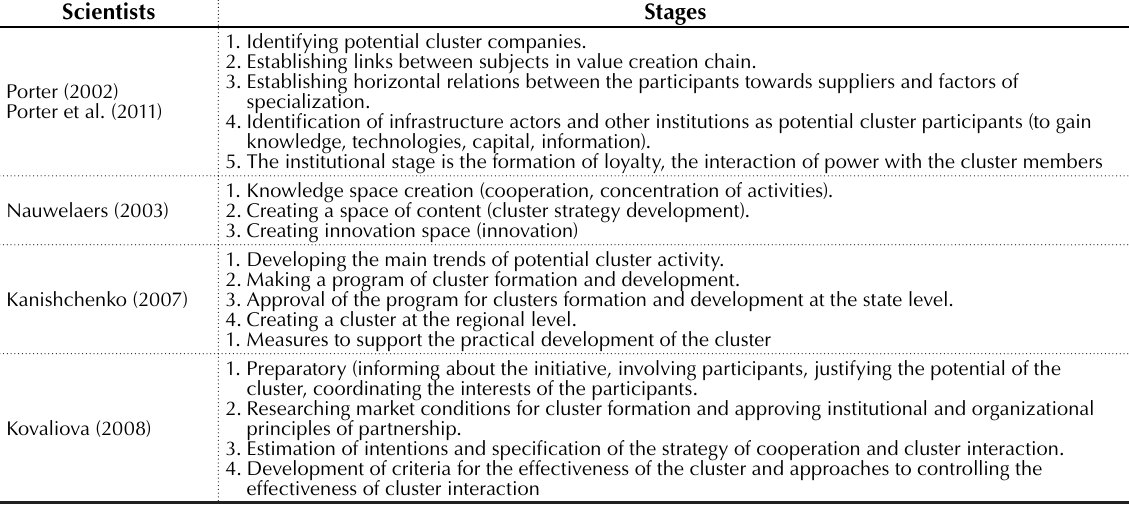
Table 1. Grouping scientific views of stages of cluster formation and development